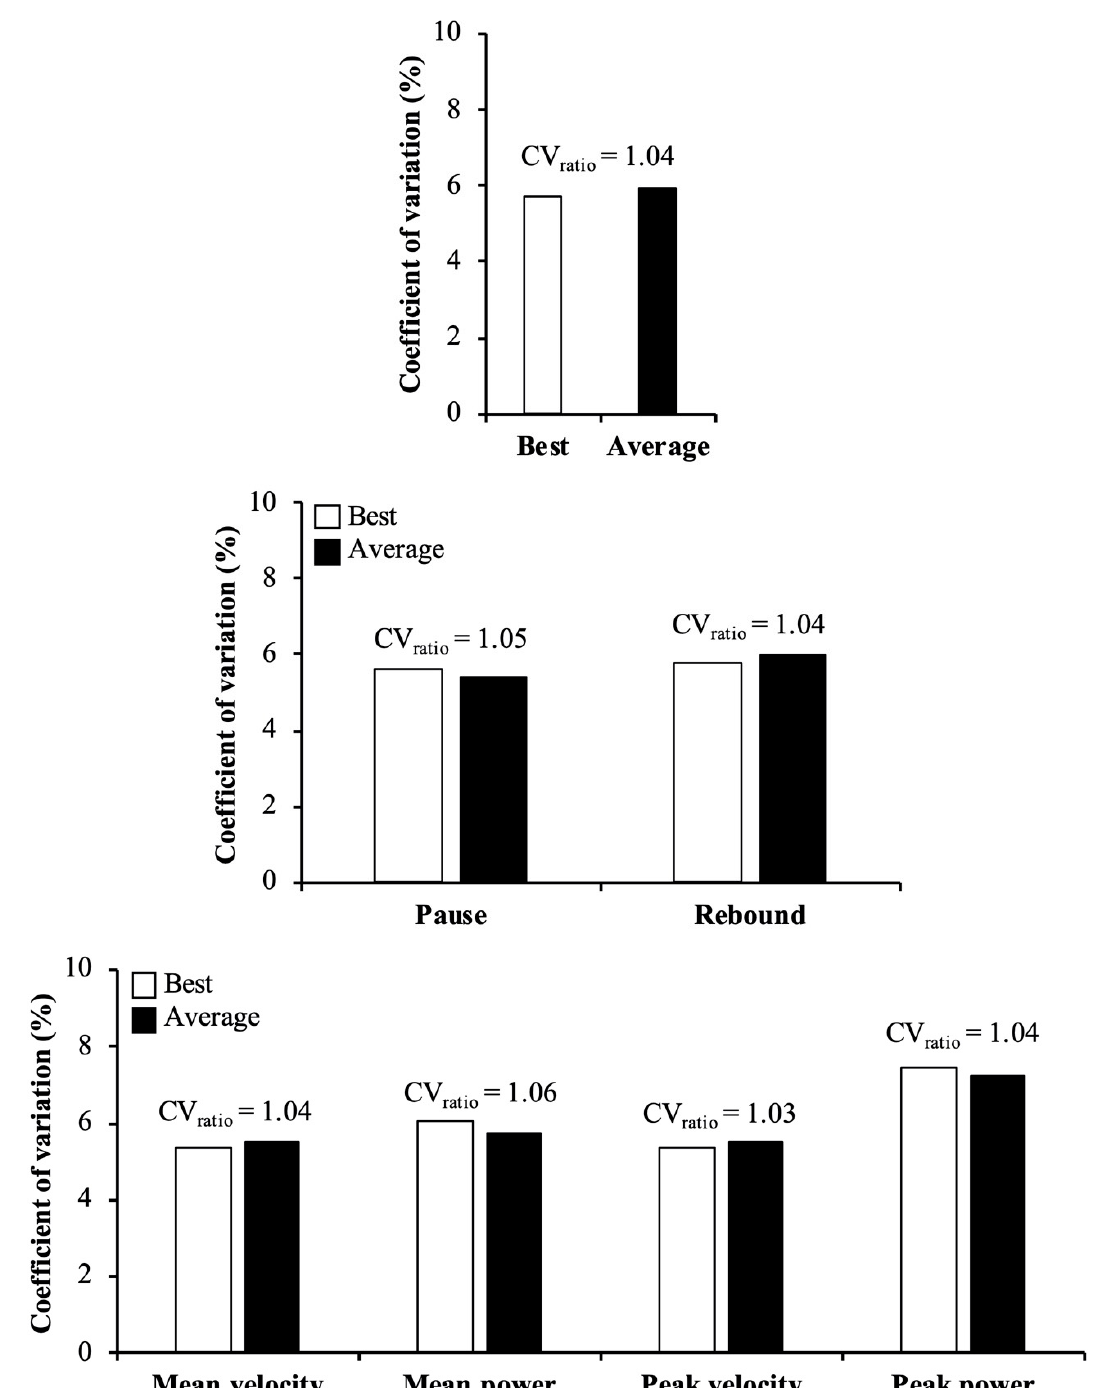
Figure 2. Reliability comparisons between pause (white bars) and rebound (black bars) techniques of the back-squat exercise. Bars represent the median coefficient of variation value obtained combining the 2 repetition criteria and 4 variables (upper panel), the 4 variables separately for each repetition criterion (middle panel), and the 2 repetition criteria separately for each variable (lower panel). Numbers depict the ratio between 2 coefficients of variation (CV ratio = higher/lower value), while meaningful differences in reliability are indicated in bold (CV ratio > 1.15).